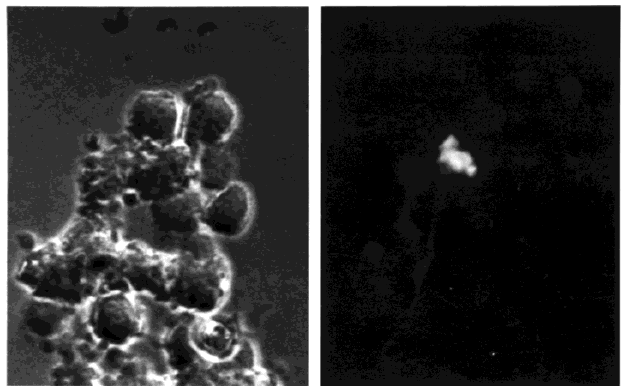
Figure 9. Cell cluster formation by PBMC exposed to FITC-labeled influenza virus (60× image). Cells were examined one hour after exposure to virus (MOI = 3) and examined by light (left panel) and fluorescence microscopy (right panel; same field as left) after addition of ethidium bromide to eliminate detection of green fluorescence associated with bound virus that is external to cell membranes.